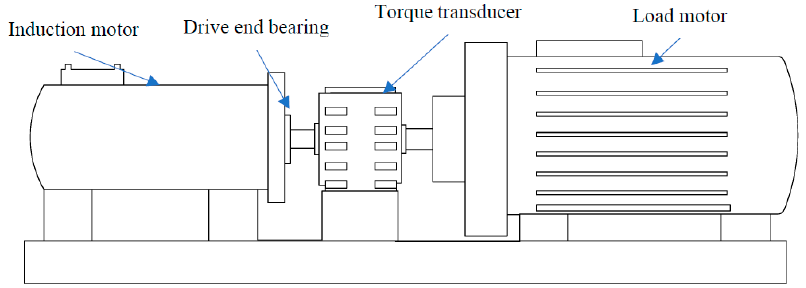
Figure 6. Case Western Reserve University Bearing Test Bench.